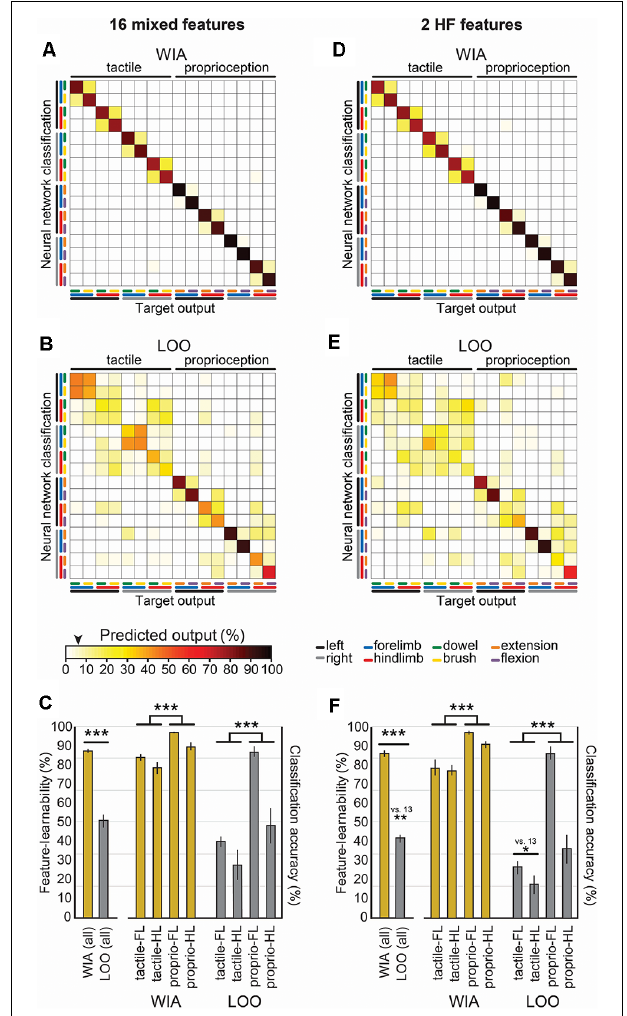
FIGURE 5 | Feature robustness across animals. Confusion matrix means are shown for WIA and LOO machine-learning models. These models use identical neural network architecture extracted from 1,000 ms post-stimulus onset, but differ by their training, validation, and testing data partitioning approaches. (A) The confusion matrix shows the mean values derived using the WIA approach for all six individual animals using the 13 mixed features that constitute the 1,000 ms feature-learnability benchmark ( Figure 3 ). The WIA approach partitions training, validation, and testing datasets from within individual animals (Loutit et al., 2019), thus machine-learning models are optimized for each animal. (B) The confusion matrix shows the mean values derived using the LOO approach for all six individual animals on the same input data set as (A) . The LOO approach trains machine-learning models from all other ( n = 5) animals and tests on the remaining animal, and thereby quantifies feature-learnability for each animal against the background of all others. (C) A comparison of the feature-learnability (left bars) for the WIA (gold bars) and LOO (gray bars) approaches are shown [derived from the means ± SEM of the diagonals in (A,B) respectively]. The large significant reduction of feature-learnability indicates that a large portion of information encoded in the signal features was unique to individual animals, but that a significant portion also generalizes across animals. The right bars show classification accuracy for stimulus classes across limbs (derived from means ± SEM calculated from the six confusion matrices from all animals) for WIA (gold) and LOO (gray) approaches. LOO output demonstrates ( Continued